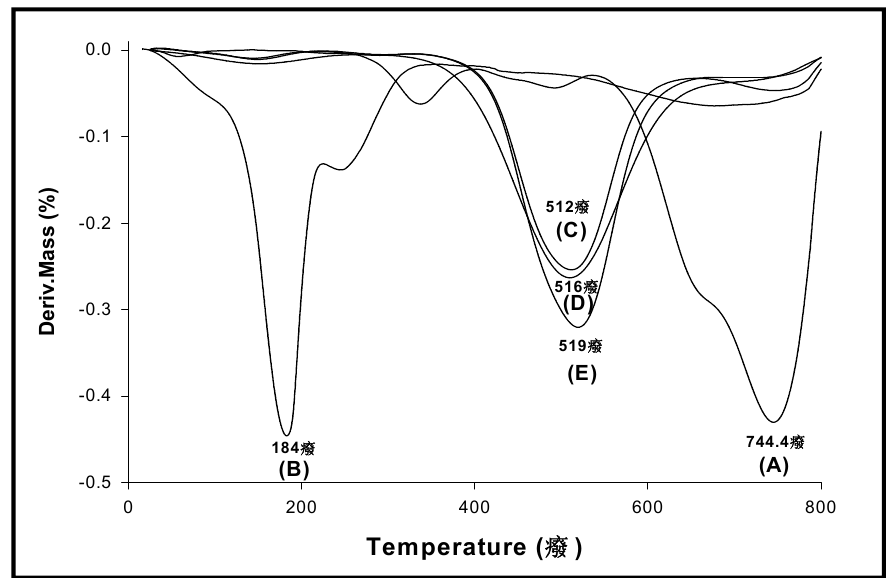
Figure 14. First derv. of thermograms showing thermal decomposition temperature for Gr(A), GrO(B), Ar neat(C) and ArGr (D) and ArGrO(E) both with 8 wt.% graphene.